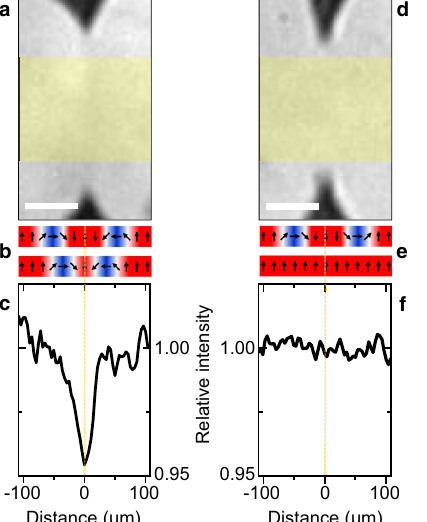
Fig. 3 Non-coalescing and coalescing multiferroic domains. a Meeting of two multiferroic + M 1 domains obtained following the procedure as in Fig. 2a – c. The sense of rotation of the order parameter across the + M 1 → − M 1 domain wall is the same for both + M 1 domains. b Order-parameter orientation (arrows) across the boundary of the + M 1 walls before (top) and after (bottom) the meeting of the + M 1 domains. c Horizontal intensity scan of the image in a , vertically averaged across the area hatched yellow. The intensity dip indicates the formation of a 360 ∘ domain wall between the + M 1 domains. d – f Same as a – c , but with opposite sense of rotation of the order parameter across the + M 1 → − M 1 domain wall for the two + M 1 domains. Here the + M 1 domains coalesce into a single domain. Scale bars, 100 μ m.